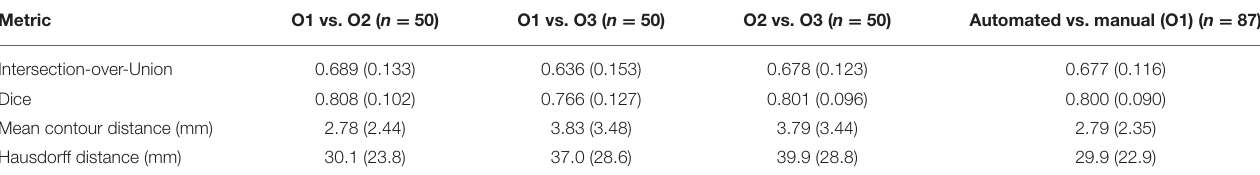
TABLE 1 | Standard segmentationperformance metrics for pairwise comparisons of manually contoured PAT by 3 observers (O1–O3), and comparing automated segmentation with manual for the test set. Metric Intersection-over-Union